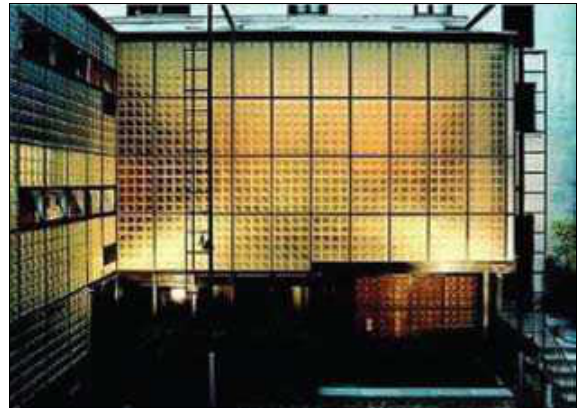
Fig. 7. “Shocken” shopping centre (arch. e. Mendelsohn), Fig. 8. Dwelling house “Maison Verre” (archs. P. chareau and b. bijvoet), Paris, 1931